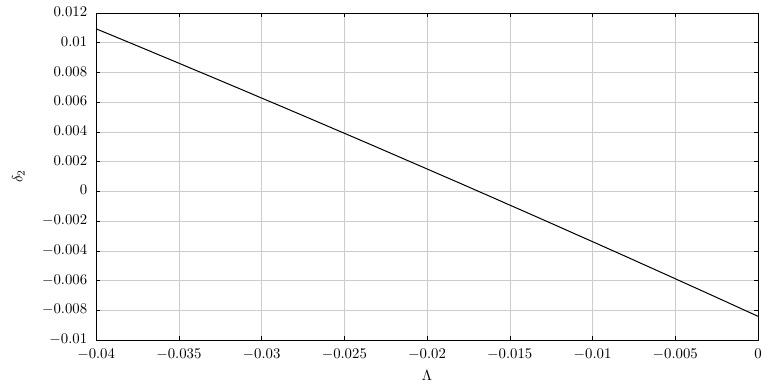
Figure 10 . The relative excess energy for the old baby potential for di(cid:11)erent values of (cid:3). Here (cid:21) = (cid:22) = 1 and (cid:20) 2 = 0 : 1.